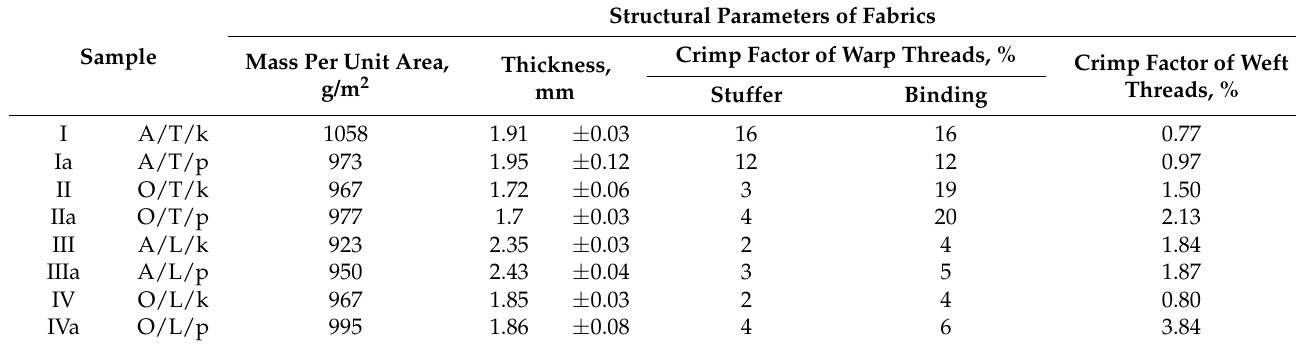
Table 3. Summary of structural parameters of